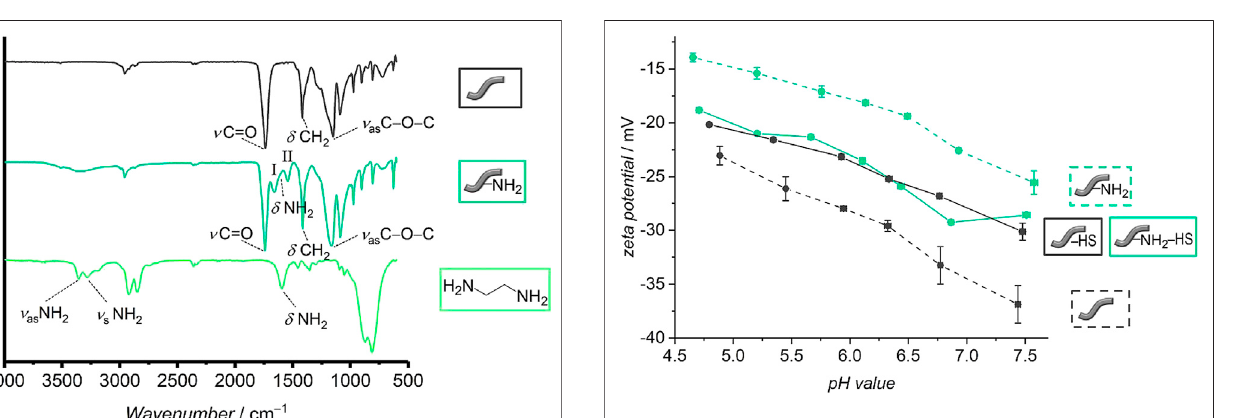
FIGURE 5 | pH-dependent zeta potential titration curves of unmodi fi ed (dashed grey line) and amino-modi fi ed (dashed green line) fi bers as well as for those fi bers coated with heparan sulfate: unmodi fi ed fi bers (continuous grey line) and amino-modi fi ed fi bers (continuous green